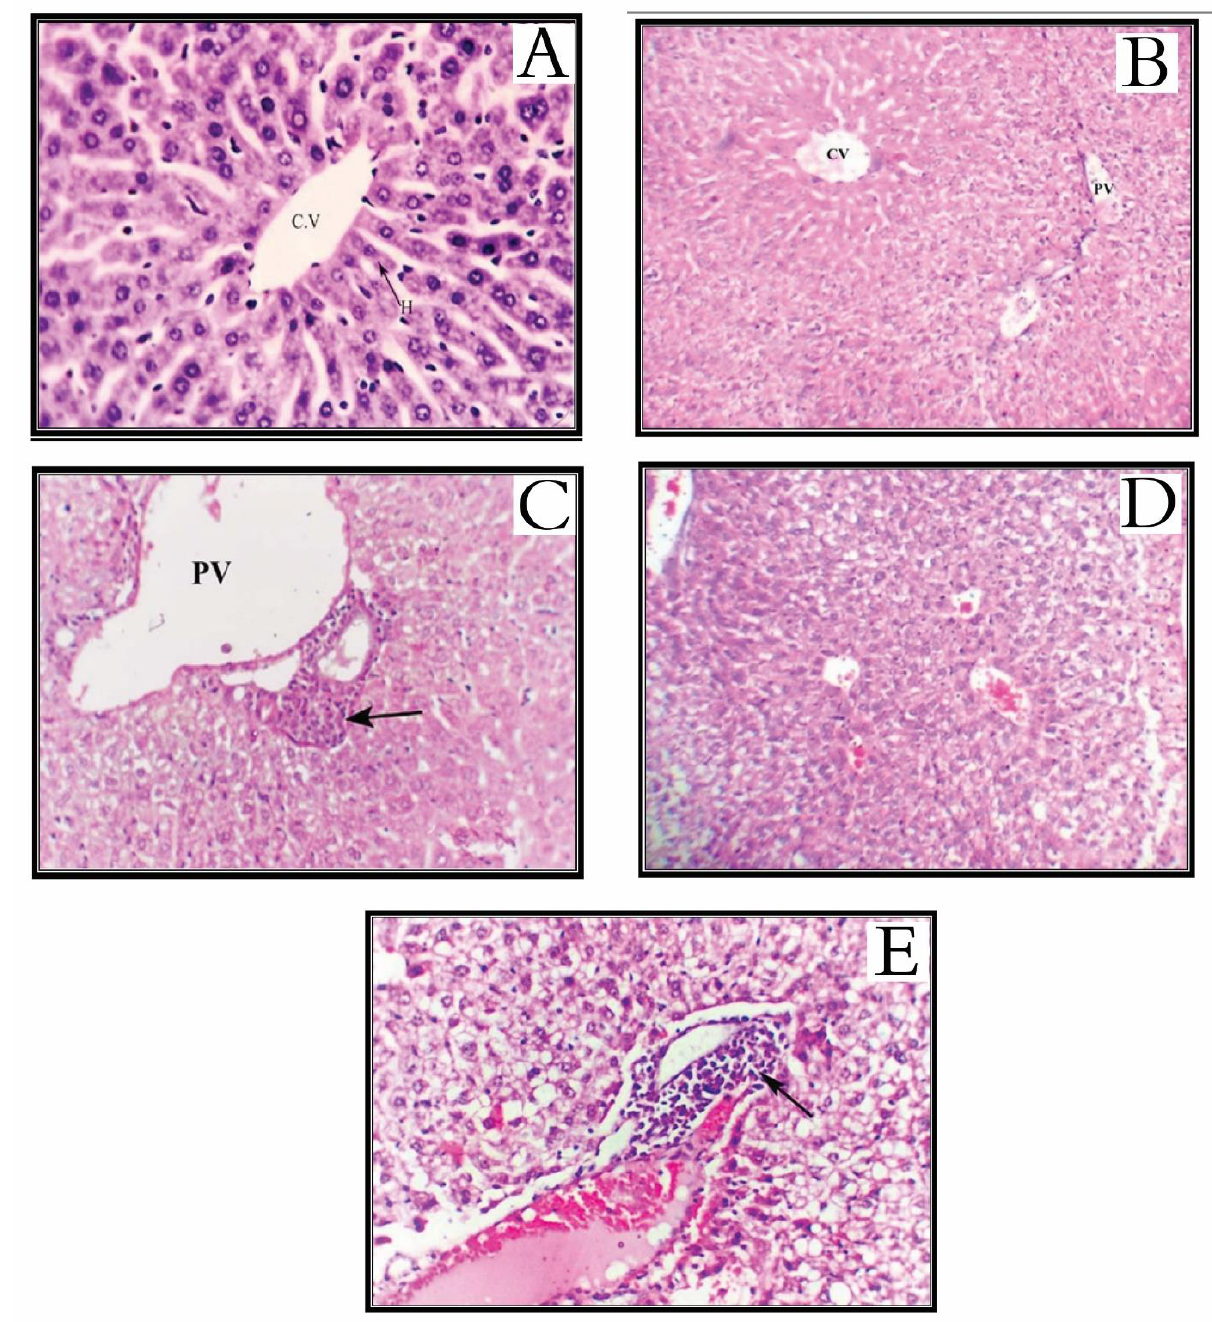
Figure 5. ( A ) Liver section of normal mouse showing cords of hepatocytes (H) radiating from the central vein (C.V) and separated by blood sinusoids (H and E × 400). ( B ) Liver section of normal mouse treated with compound 6a showed preserved lobular architecture with mild degenerative changes. Central vein (CV) and portal vein (PV) could be seen. ( C ) Liver section of a normal mouse treated with compound 6a showed mild degenerative changes and mild portal lymphocytic infiltrates (arrow) surrounding the portal vein (PV). ( D ) Liver section of normal mouse treated with compound 6b showed mild diffuse degenerative changes, mild congestion, and scattered lymphocytes. ( E ) Liver section of normal mouse treated with compound 6c showed a moderate diffuse degenerative change in the form of feathery degenerative changes. Moreover, a wide dilated portal vein and mild portal perivascular lymphocytic infiltrates (arrow) are seen. (×200 H and E).